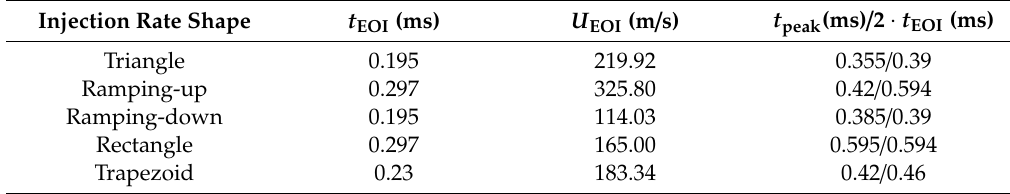
Table 3. Calculation results of t EOI and U EOI for injection quantity of 0.833